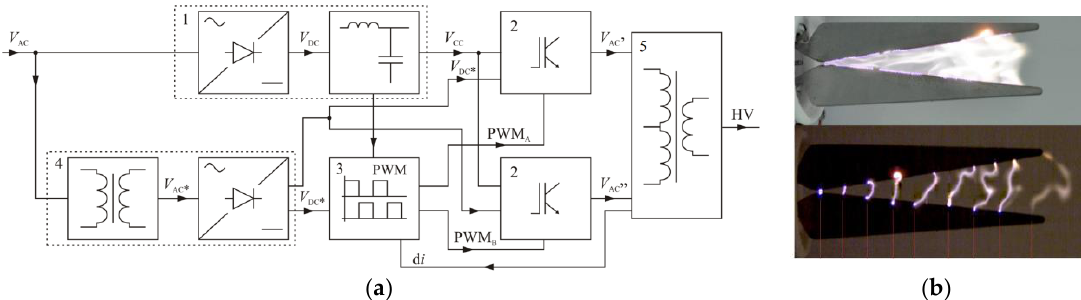
Figure 17. ( a ) Block diagram of the of NTP power supply for 2 electrode GAD reactor, based on push—pull topology, 1—AC / DC bus with, 2—twin current control modules, 3—PWM control system, 4—auxiliary DC voltage, 5—HV and HF transformer with divided primary winding, ( b ) development of the µ GAD in air at flow rate 450 dm 3 / h—above photo and below image recorded with a fast speed camera